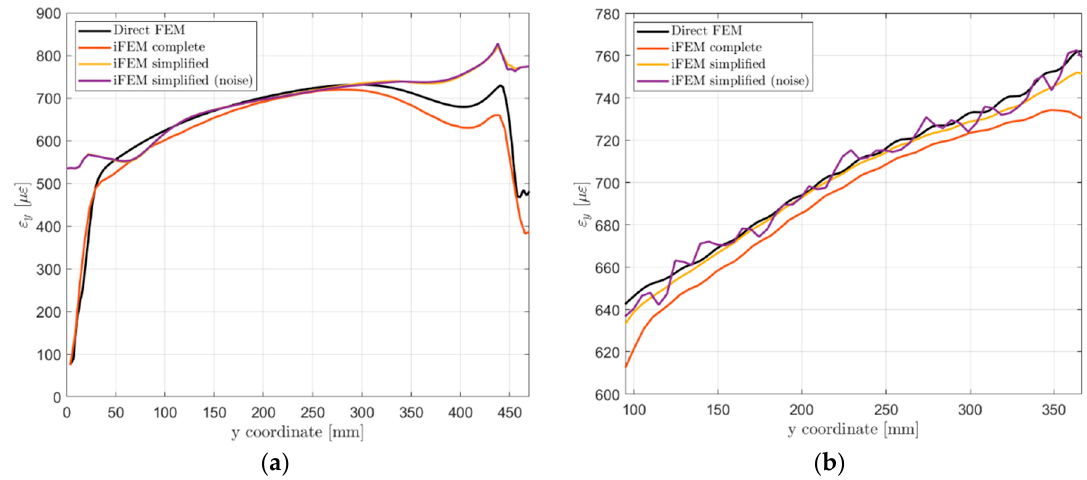
Figure 15. Out-of-plane displacement 𝑼 𝒛 comparison: ( a ) Path 1; ( b ) Path 2.